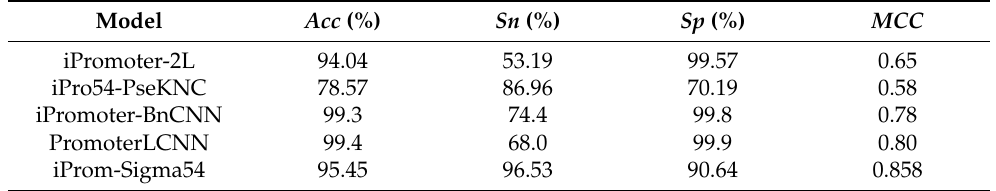
Table 3. σ 54 Promoter and non-promoter identification comparison using 5-Fold on benchmark.